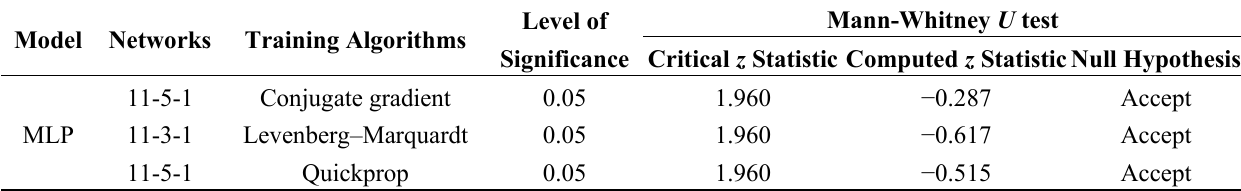
Table 3. Results of the Mann-Whitney U test.